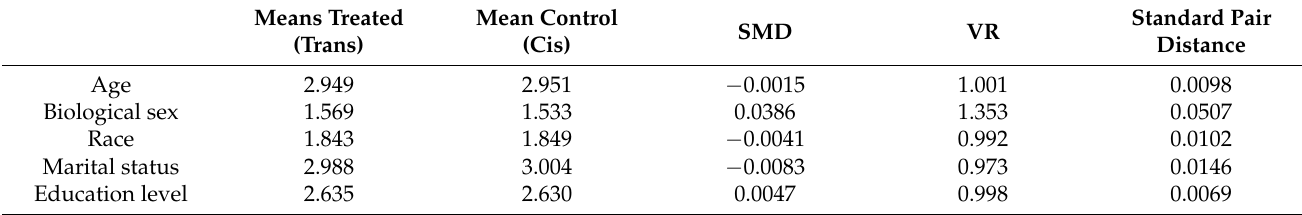
Figure 1. Love plot displaying covariate balance in unadjusted and adjusted samples. Legend: Absolute standardized mean differences close to zero and variance ratio close to one is indicative of a good covariate balance. Table 2. Summary of covariate balance for matched cohort units ( N =